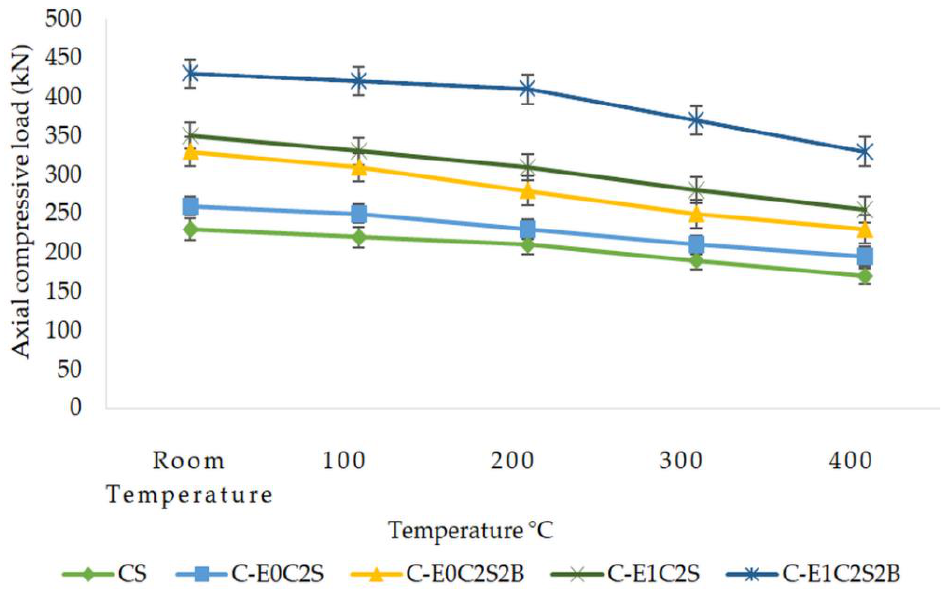
Figure 11. Maximum compressive load comparison of unconfined and confined specimens exposed to elevated temperatures.